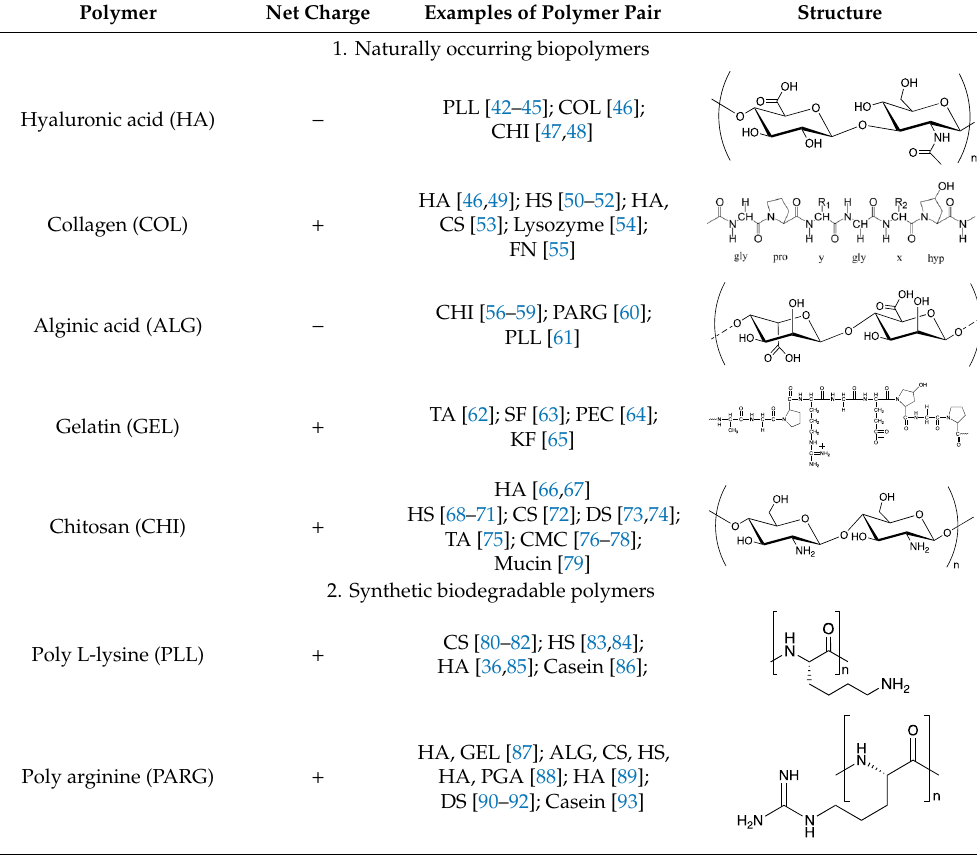
Table 1. Biopolymers and synthetic biodegradable polymers that are frequently used for the fabrication of PEMs. ALG—Alginic acid, CHI—Chitosan, CMC—Carboxymethylcellulose, COL— Collagen, CS—Chondroitin sulphate, DS—Dextran sulphate, FN—Fibronectin, GEL—Gelatin, HA— Examples of Polymer Pair Structure 1. Naturally occurring biopolymers